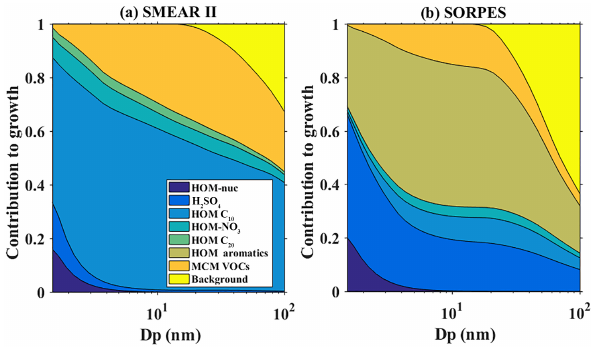
Figure 7. The relative contributions of precursor vapours to the growth of sub-100nm particles at (a) SMEAR II and (b)